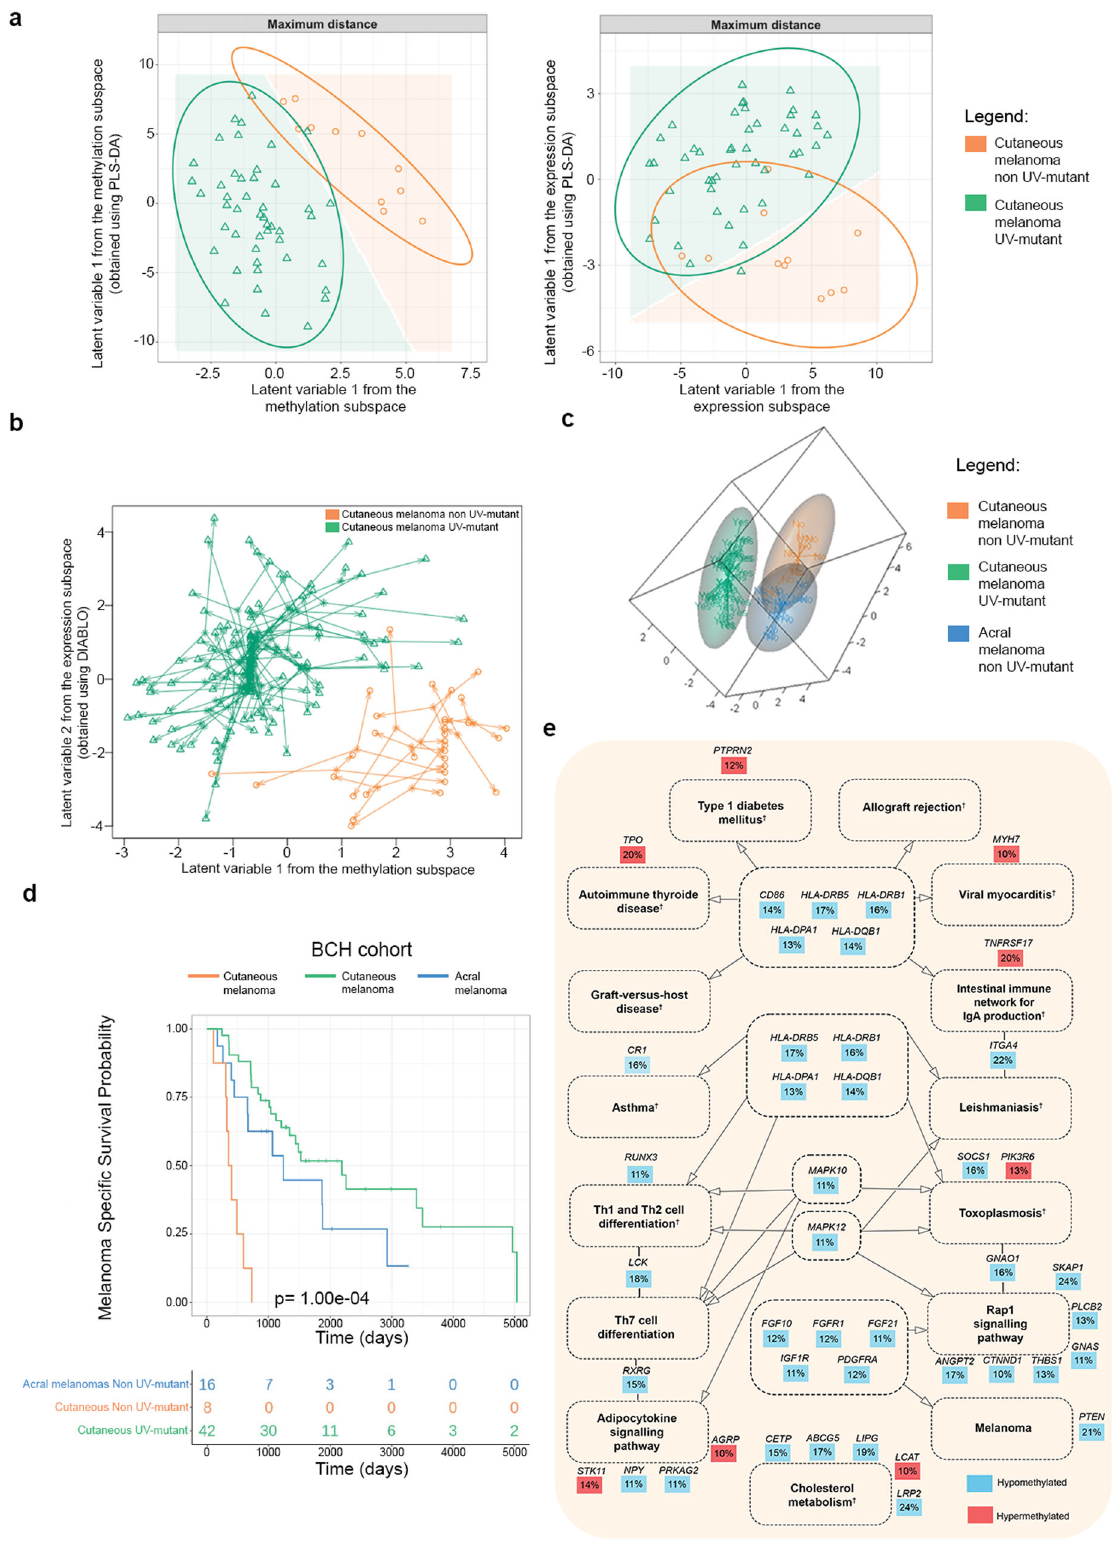
methylation alterations showed similar distributions between BCH and TCGA in hypo- and hypermethylated regions as well as similar enrichments in regulatory and CpG density regions, in skin disorders and in immunological pathways. Among the CpGs and genes differentially methylated in both BCH and TCGA, methylation levels of TAPBP (encompassing several